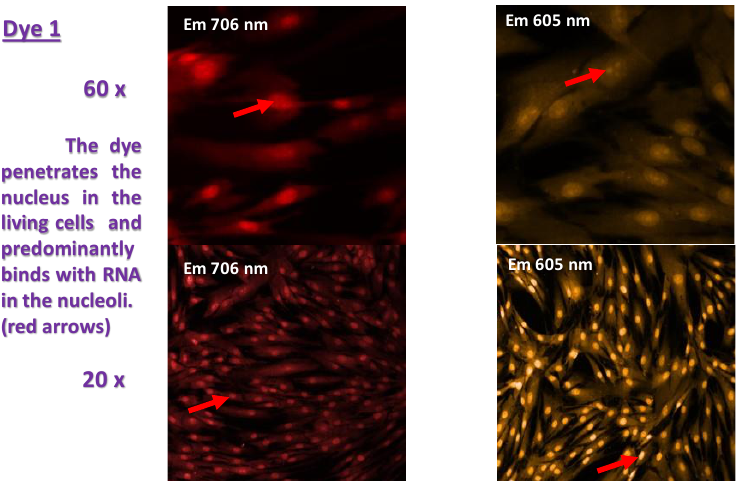
Figure 1. ( A ) Absorption spectra of dye 1 in TE buffer neat and in presence of dsDNA; ( B ) Fluores- cence spectra of dye 1 in TE buffer neat and in presence of dsDNA.